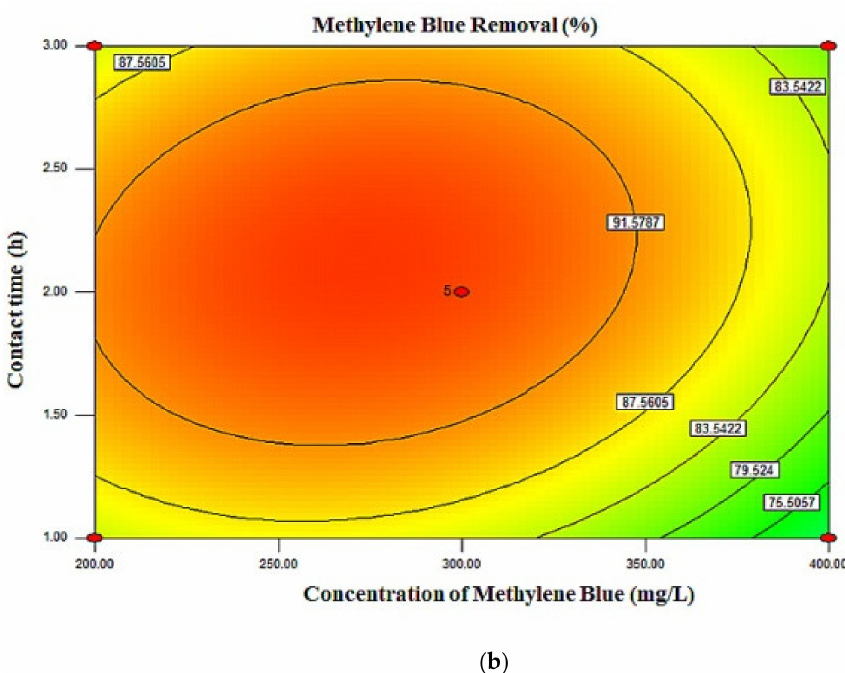
Figure 7. ( a ) 3D surface plot and ( b ) 2D contour plot for the effect of MB concentration and contact time on MB removal percentage.